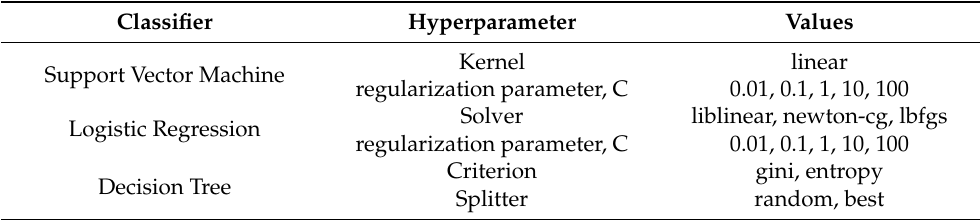
Table 3. Hyperparameters